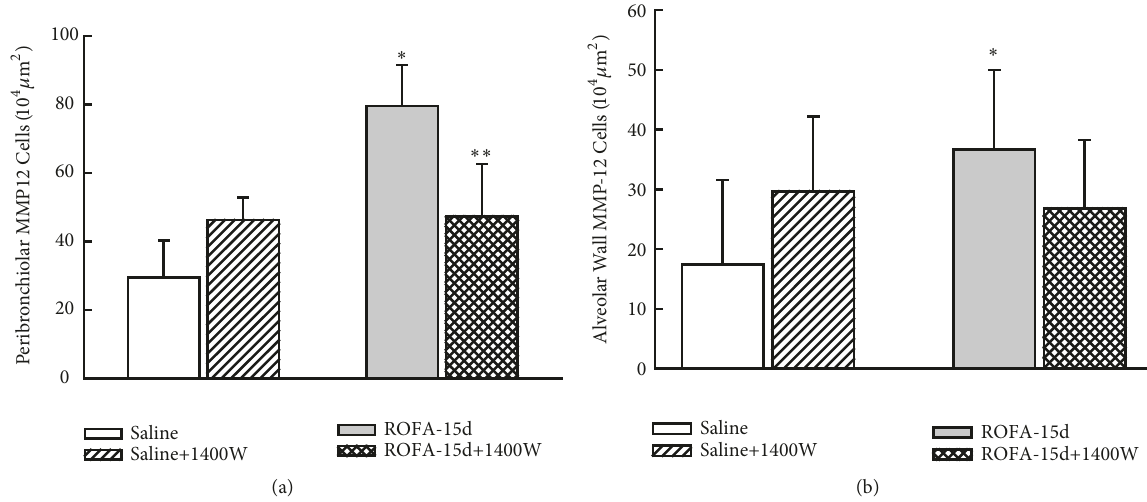
Figure 6: Metalloproteinase12 expression. This figure representsthe mean and SEM valuesof MMP-12expression in both peribronchiolar(a) and alveolar (b) wall. The ROFA instillations increased the number of MMP-12-positive cells and iNOS inhibition significantly reduced this response only in airways. ∗ p < 0.05 compared with saline groups; ∗∗ p < 0.05 compared with animals thatreceived ROFA and